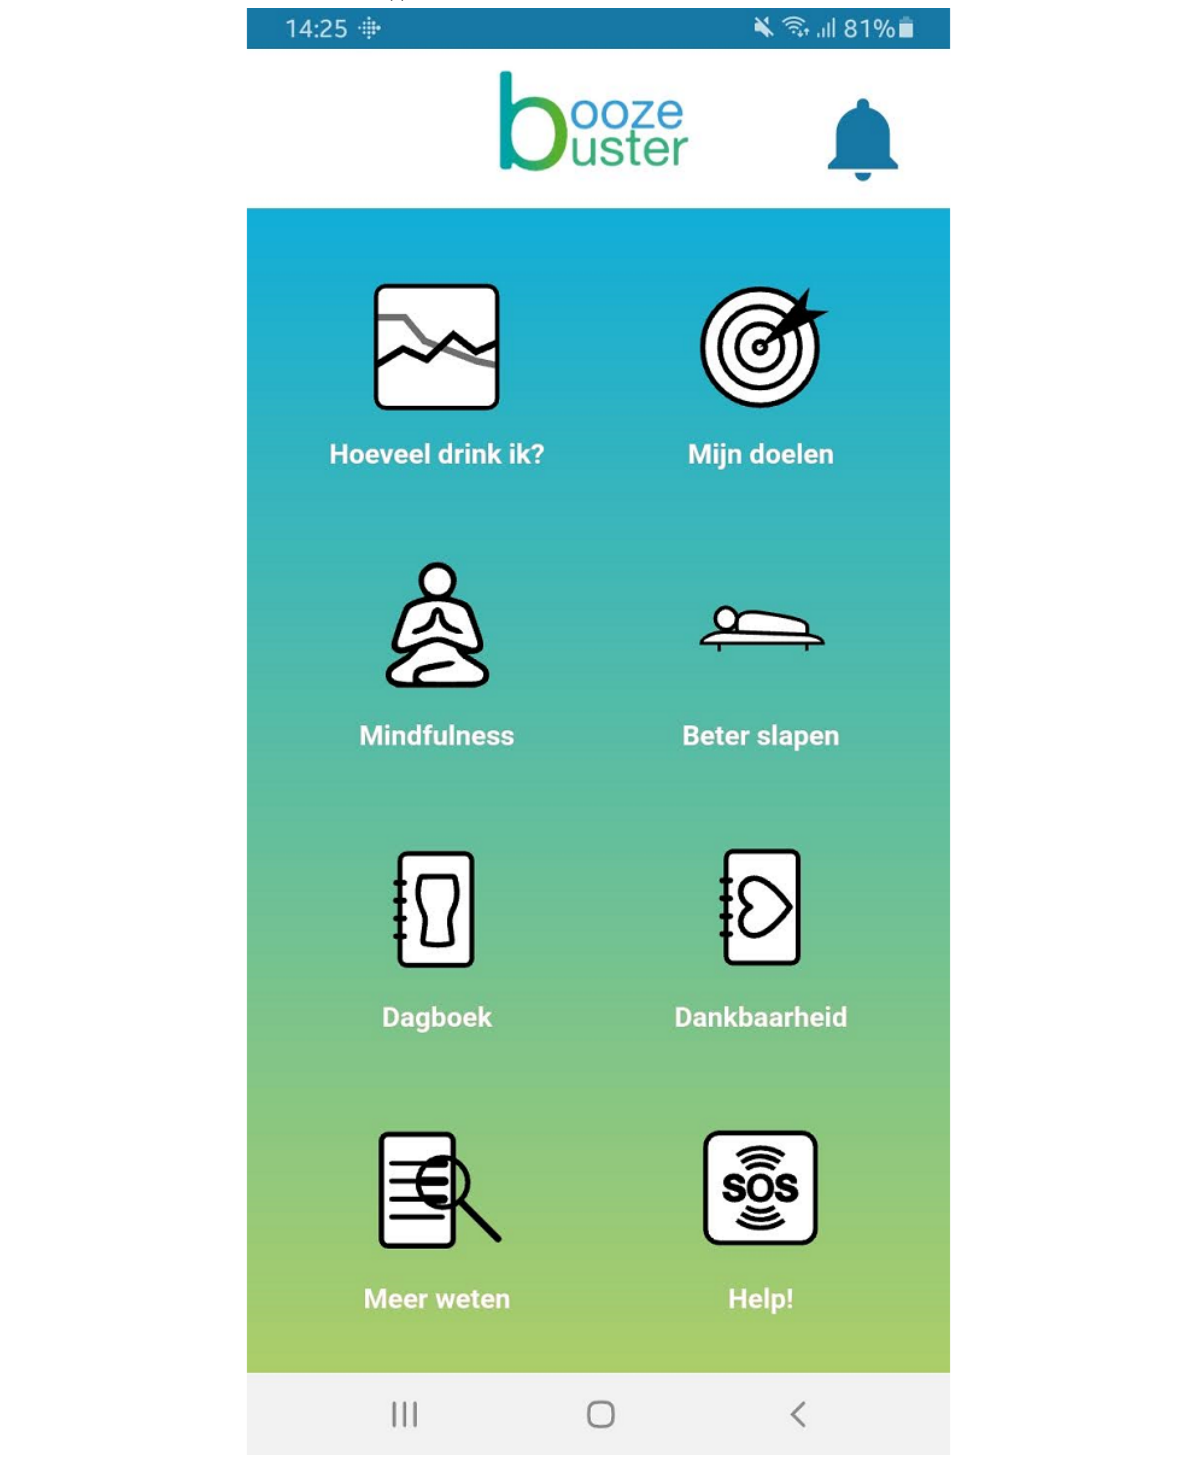
Figure 2. Screenshot of the Boozebuster mobile app (home